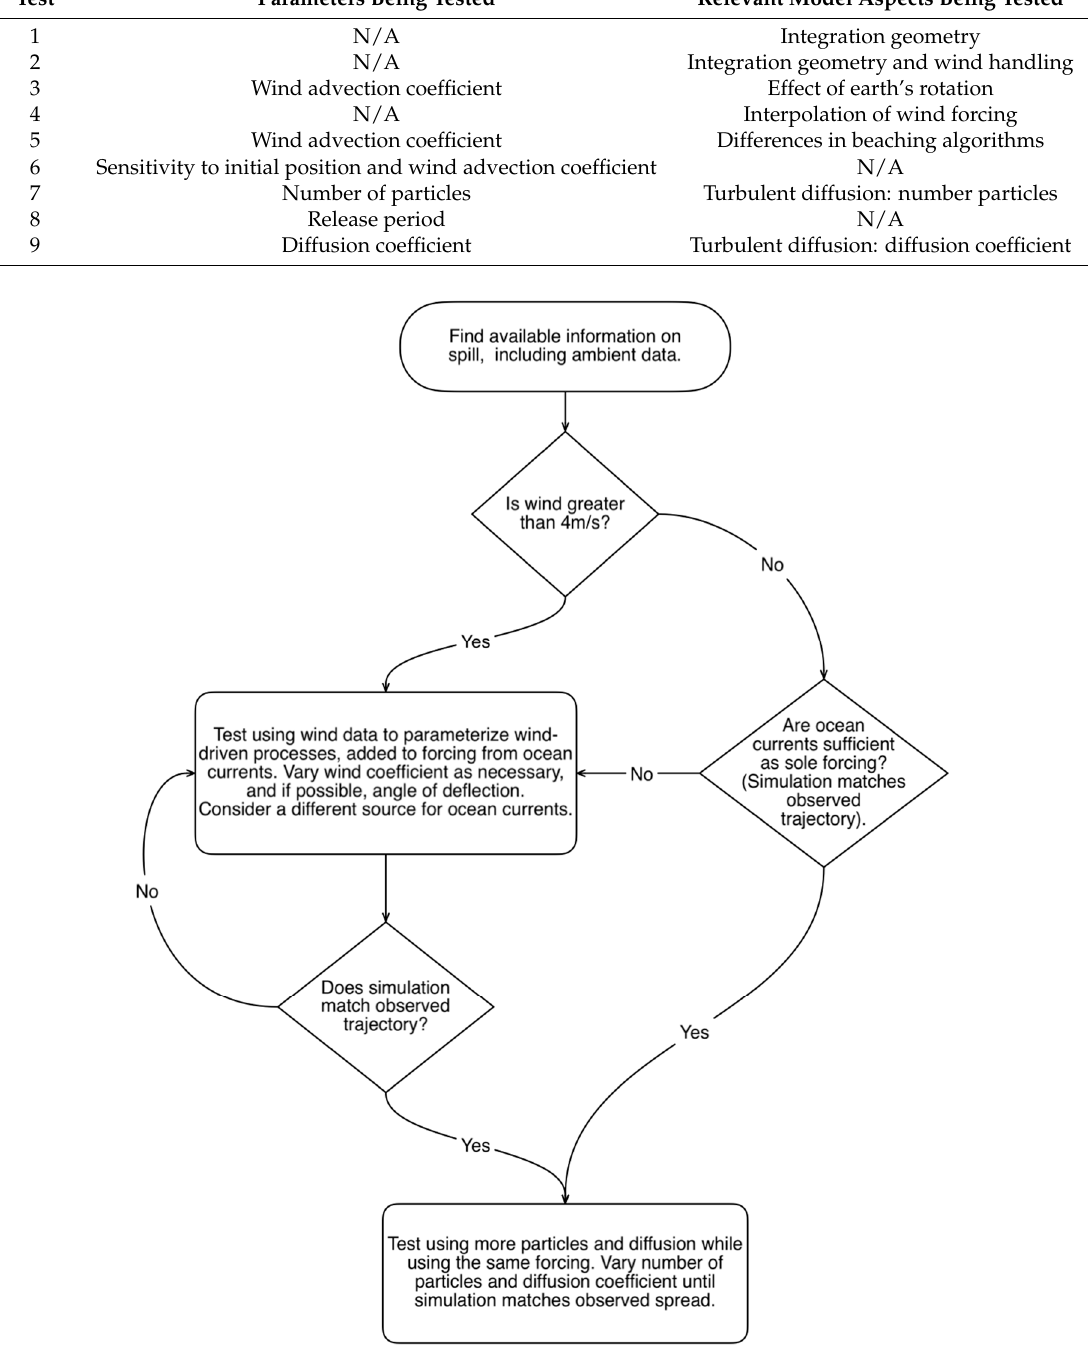
Figure 21. Diagram summarizing steps, as used in this study, for hindcasting an oil spill.